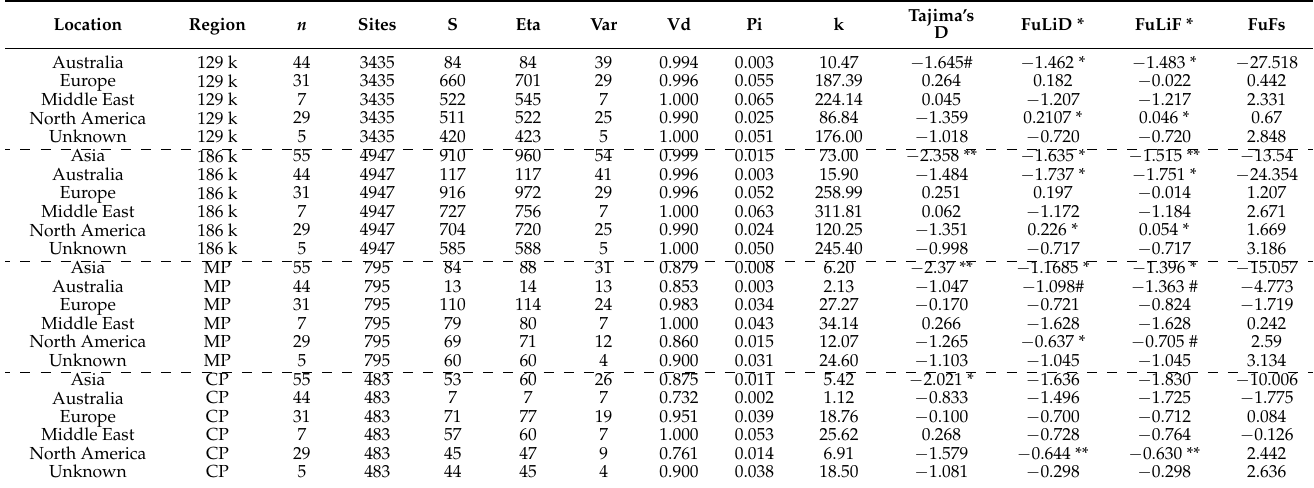
The table includes the following data: n —number of sequences; Sites—number of nucleotides analysed; S—number of segregating/polymorphic sites; Eta—total number of mutations; Var—number of variants; Vd—va- riant diversity; Pi—nucleotide diversity; k—average number of nucleotide differences; Tajima’s D; FuLiD *—Fu and Li’s D *-test statistic; FuLiF *—Fu and Li’s F *-test statistic; FuFs—Fu’s Fs statistic. Tajima’s D: * p >